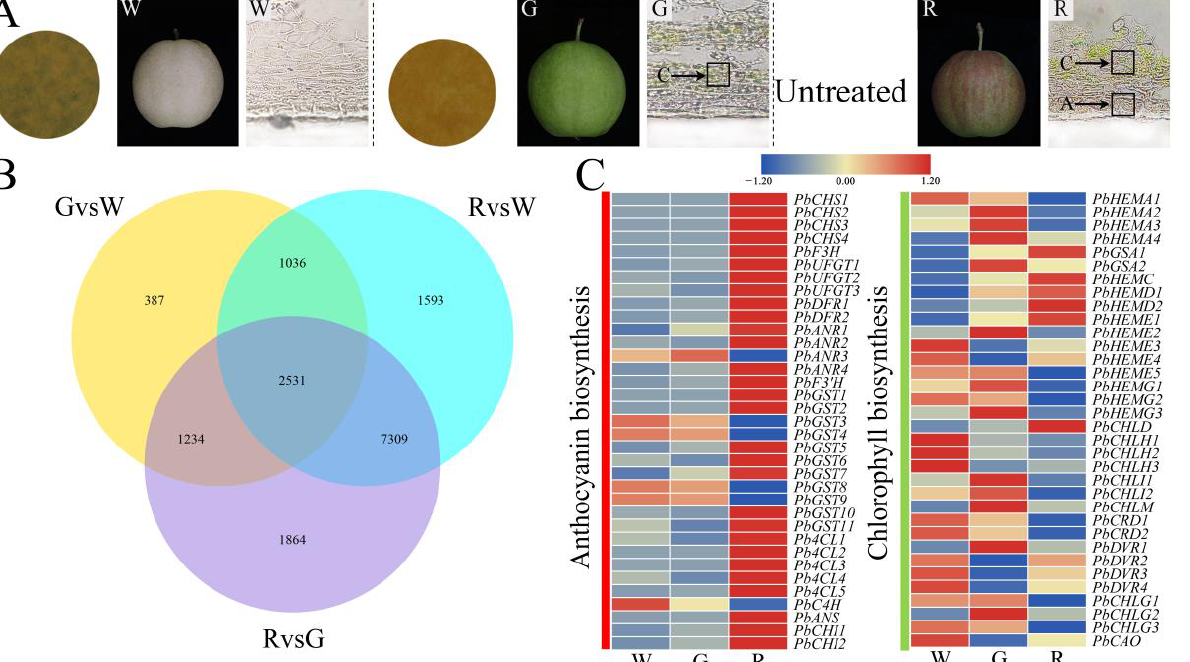
Figure 2. Transverse sections of the pericarp of bagged ‘Xinqihong’ pear fruit, and analysis of differentially expressed genes (DEGs): ( A ) Anatomy of the skin of ‘Xinqihong’ fruit treated with different types of fruit bags. ( B ) Venn diagram of DEGs in the skin of bagged (W and G) and unbagged (R) fruit detected by RNA sequencing. ( C ) Relative expression of candidate genes associated with the anthocyanin and chlorophyll synthesis pathways. W: Brown–black-bag-treated fruit; G: yellow–white-bag-treated fruit; R: fruit not bagged.